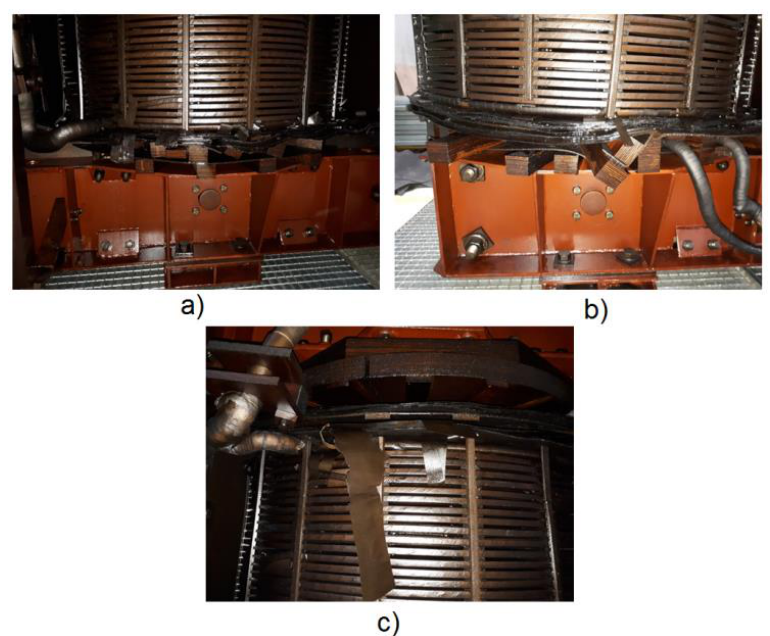
Figure 7. The damages identified during an internal inspection of the 40 / 20 / 20 MVA, 115 / 16.5 / 16.5 kV power transformer: ( a ) Loose and damaged clamping elements, ( b ) windings deformation, and ( c ) gaps in the elements solid insulation.